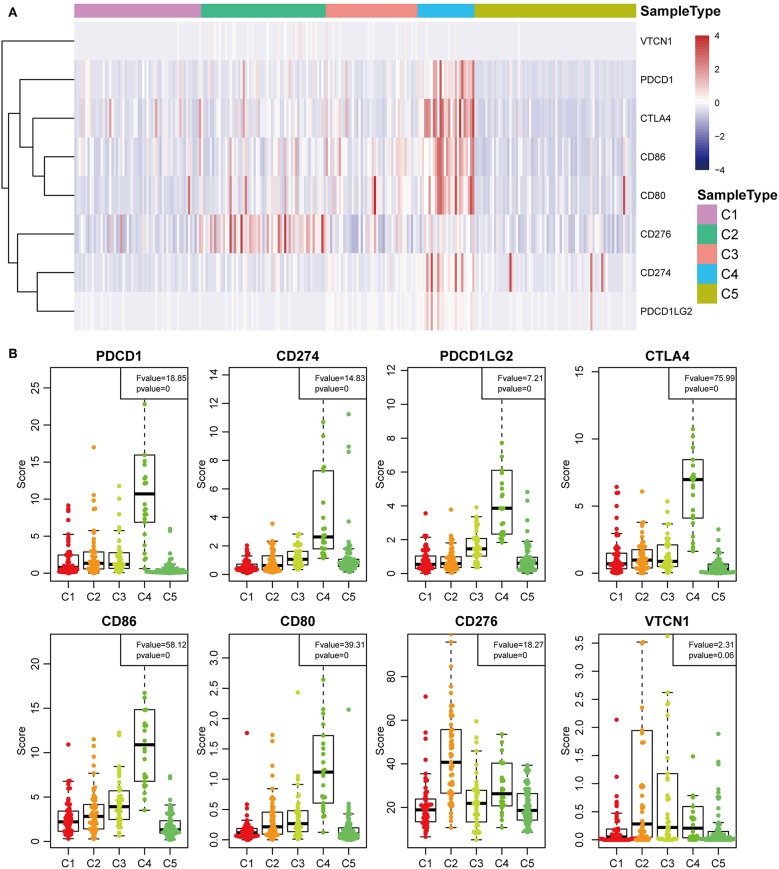
Identification of the five HCC subtypes in THE TCGA cohort. (A) Gene expression profile of eight checkpoint molecules (VTCN1, PDCD1, CTLA4, CD66, CD60, CD276, CD274, and PDCD1LG2) across five HCC subtypes in the TCGA cohort. Five subtypes (columns) are presented by the centroids of the TCGA cohort. Heatmap showing the associated gene expression value, with red denoting high expression and blue denoting low expression. (B) The expression profile scores of eight checkpoint molecules (PDCD1, CD274, PDCD1LG2, CTLA4, CD86, CD80, CD276, and VTCN1) in the five HCC subtypes.